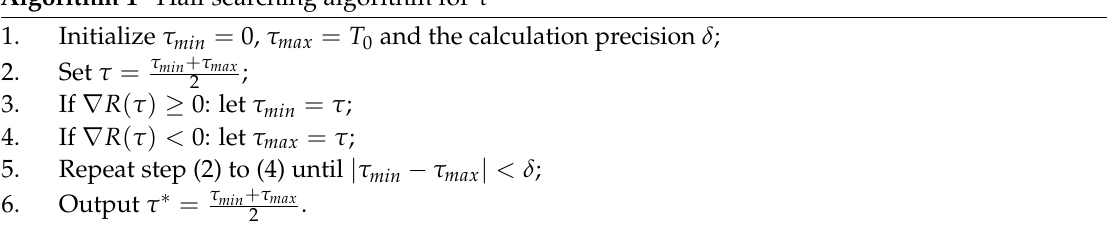
Algorithm 1 Half searching algorithm for τ